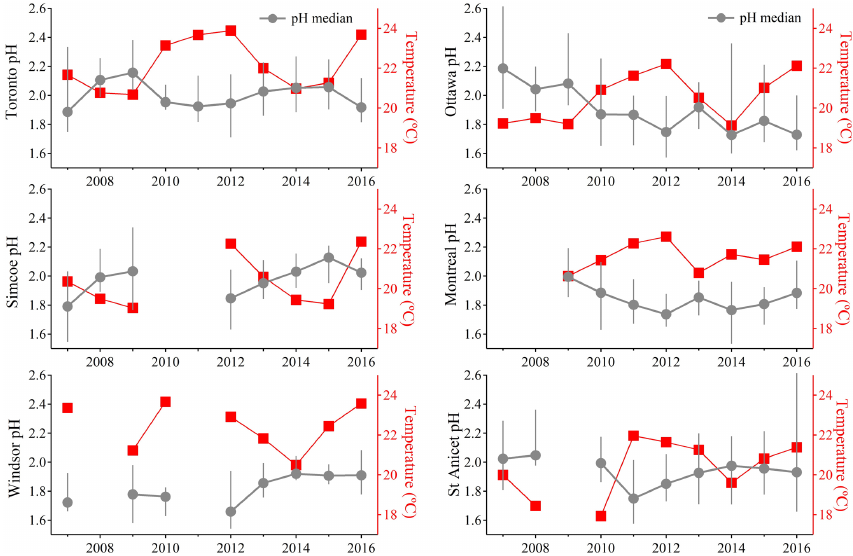
Figure 6. Median of aerosol pH in summertime (data on July and August) from year 2007 to 2016 at six monitoring sites. The error bars with median pH values represent the range from the 25th to 75th percentiles. Average ambient temperature in summertime (July and August) at each site is also plotted on right axis to illustrate the reverse trend of temperature with pH inter-annual